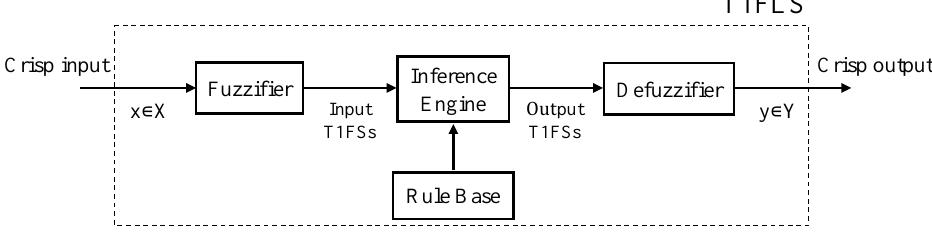
Figure 6. Structure diagram of a